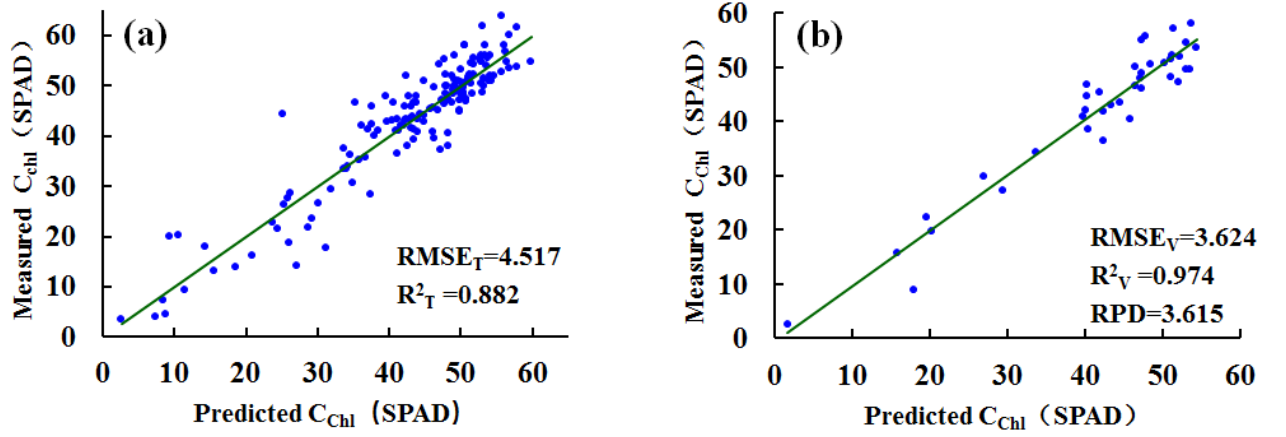
Figure 8. The estimated results of SPAD value for ( a ) training set and ( b ) validation set at mature stage.